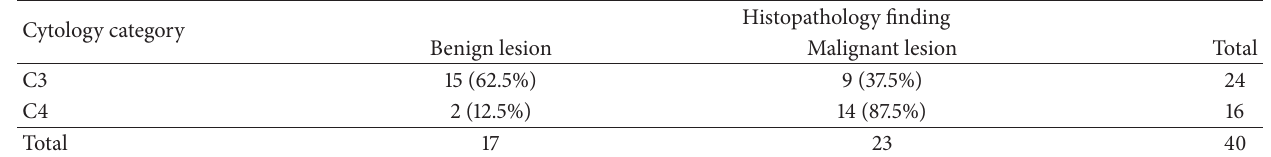
Table 1: Comparison of FNA cytology and histopathology findings.